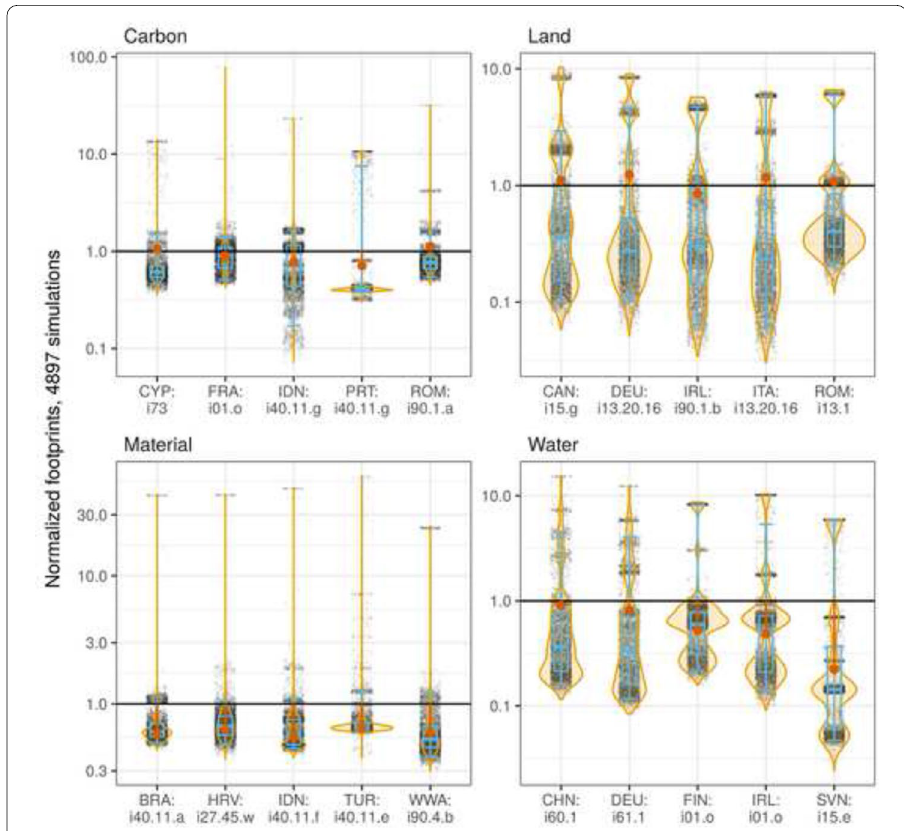
Fig. 6 The sample distributions of the industry footprints exemplary for selected industries. The footprints where normalised by dividing each sample by the mean of all 4897 samples. The violin plots show the probability density and the range of all samples. The boxplots show the IQR (boxes), the sample’s median (vertical line) and the range from the 2.5th to the 97.5th percentile (whiskers). The red points show the footprints size assuming proportional import shares, also normalised by the mean of all